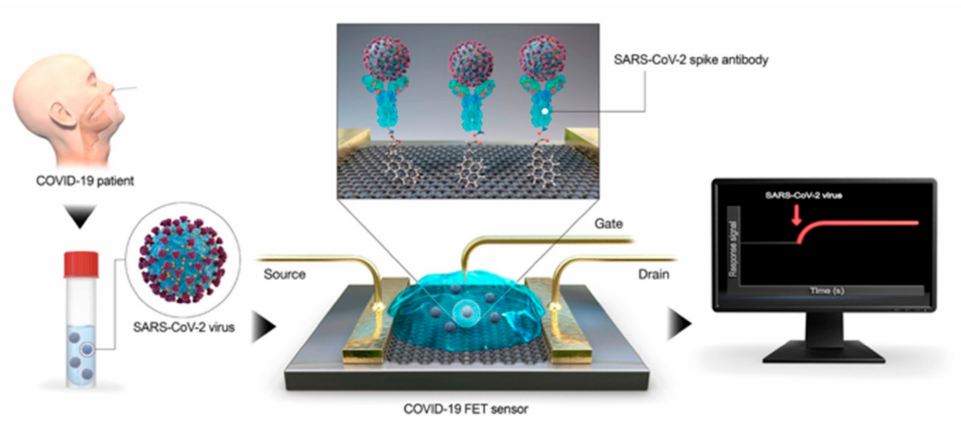
Figure 9. Detection of SARS-CoV-2 using FETs: The schematic shows a collection of biological samples from a patient and their application to the graphene-based sensing area of a FET biosensor. Binding events associated with the SAR-CoV2 virus can be captured by the sensor in real time. Reproduced with permission from [88] (further permission related to the material excerpted should be directed to the ACS). Direct link: https://pubs.acs.org/doi/10.1021/acsnano.0c04421 (accessed on 9 November